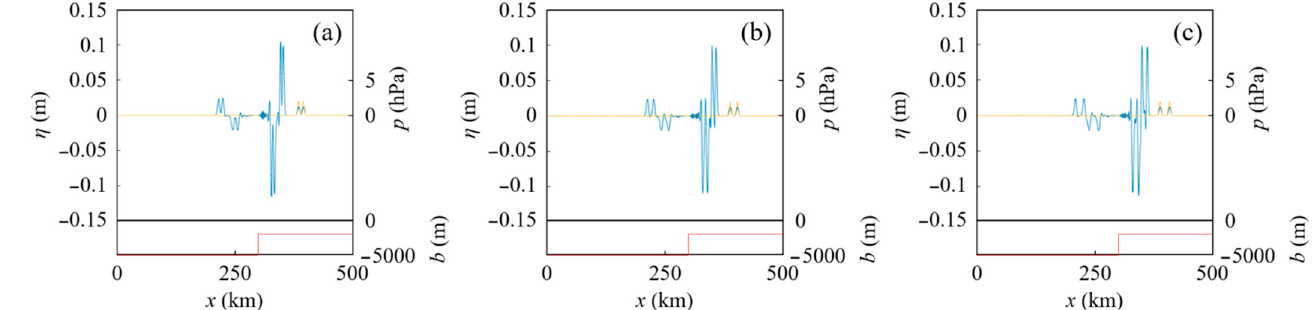
Figure 5. Water surface profiles at t = 1400 s for different intervals of the atmospheric pressure waves, δ , in Case C, in which x 2 = 40 km in Figure 1; h on = 2000 m and x on = 300 km in Figure 2a. The blue, orange, and red lines indicate the water surface displacement η , atmospheric pressure p , and seabed position b , respectively. ( a ) δ = 0 km, ( b ) δ = 5 km, and ( c ) δ = 10 km in Figure 1.